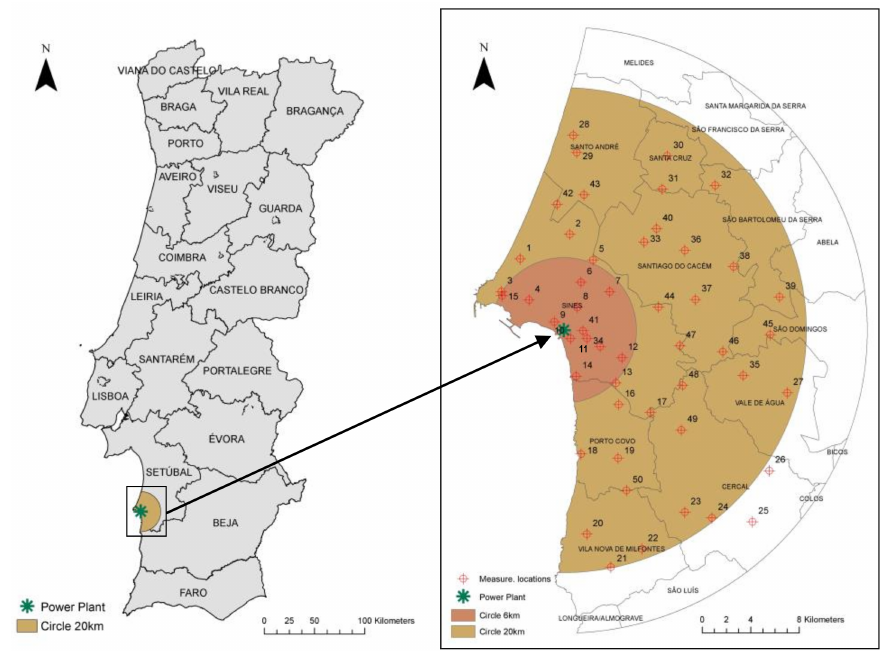
Figure 2. Study area and measurements locations